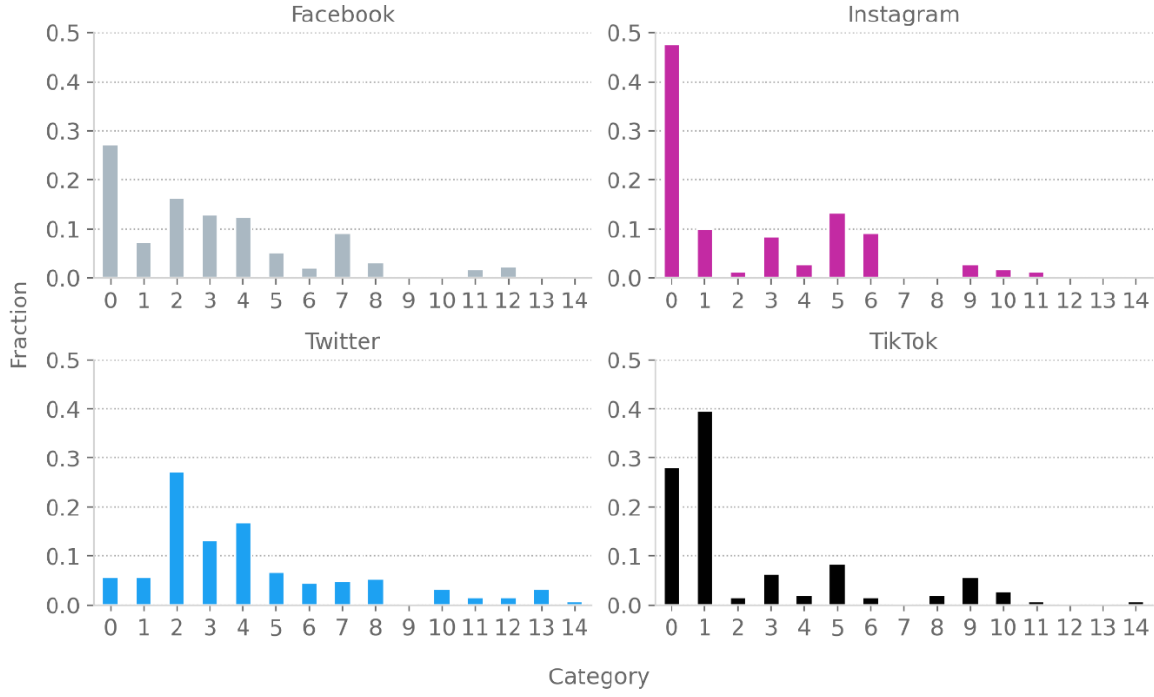
Figure 1. Share of each category of comments by social media platform.